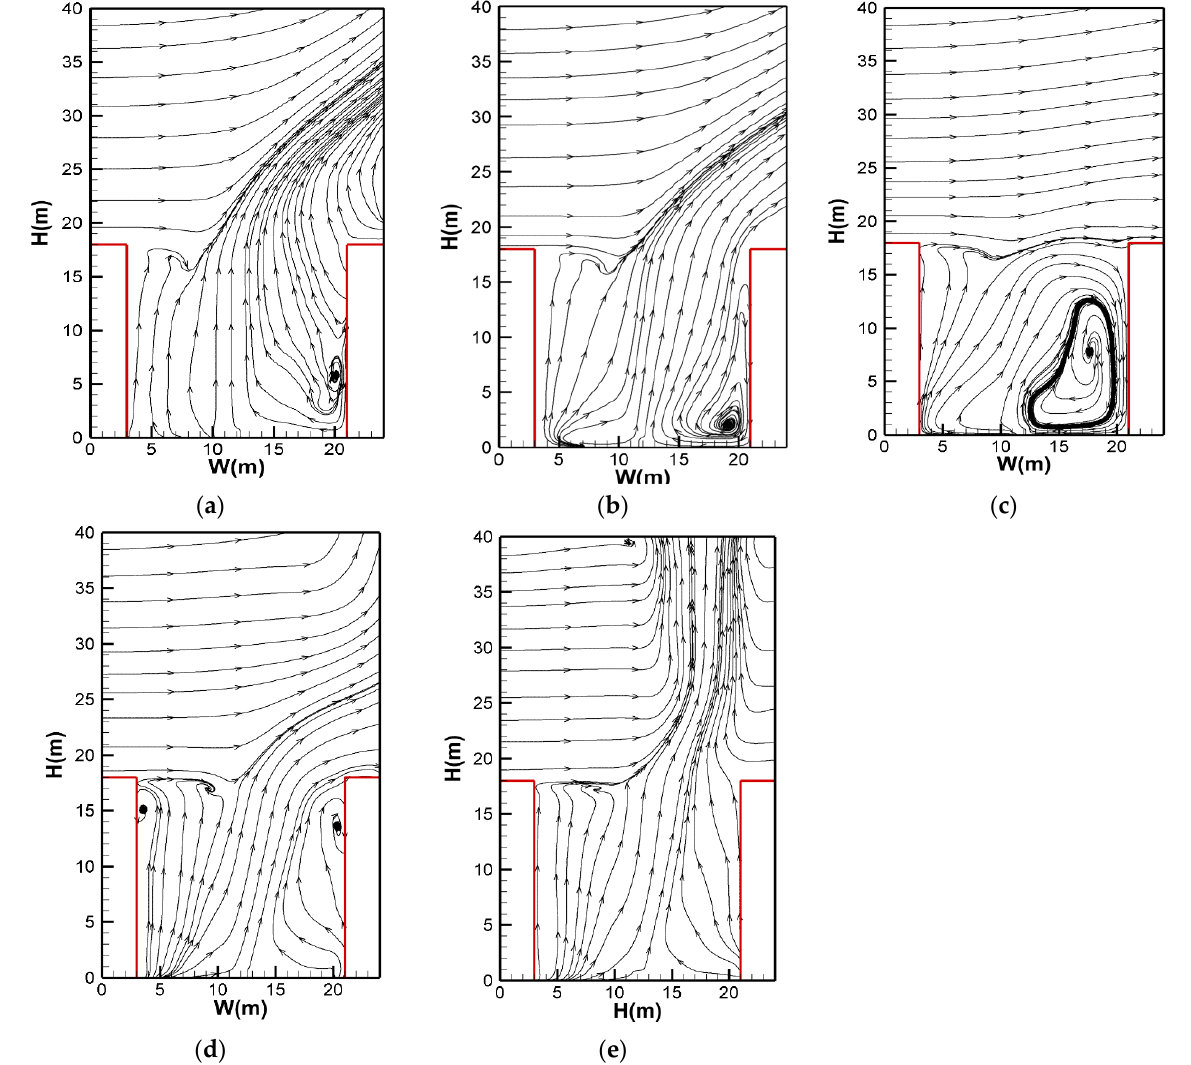
Figure 4. The time-averaged flow patterns for different wind-direction conditions: ( a ) θ = 0°; ( b ) θ = 20°; ( c ) θ = 35°; ( d ) θ = 50°; ( e ) θ = 65° (time period: 200 – 400 s).